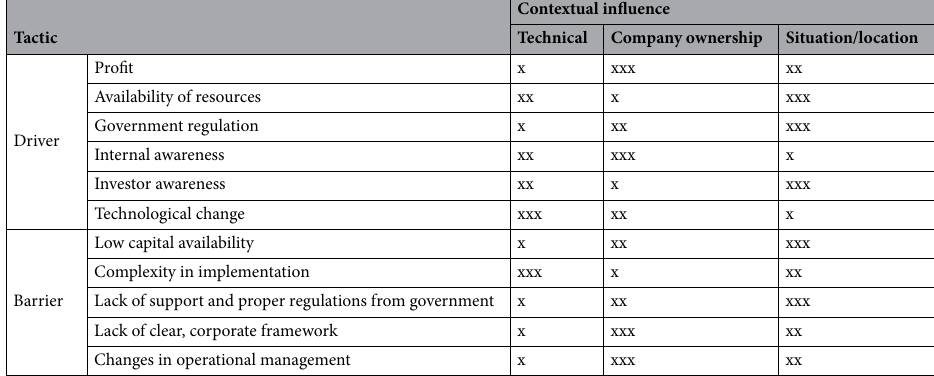
Table 1. The relationship between tactics and contextual influences in an Indonesian cement company. xxx— Strongly related, xx—Related, x—Limited/weakly